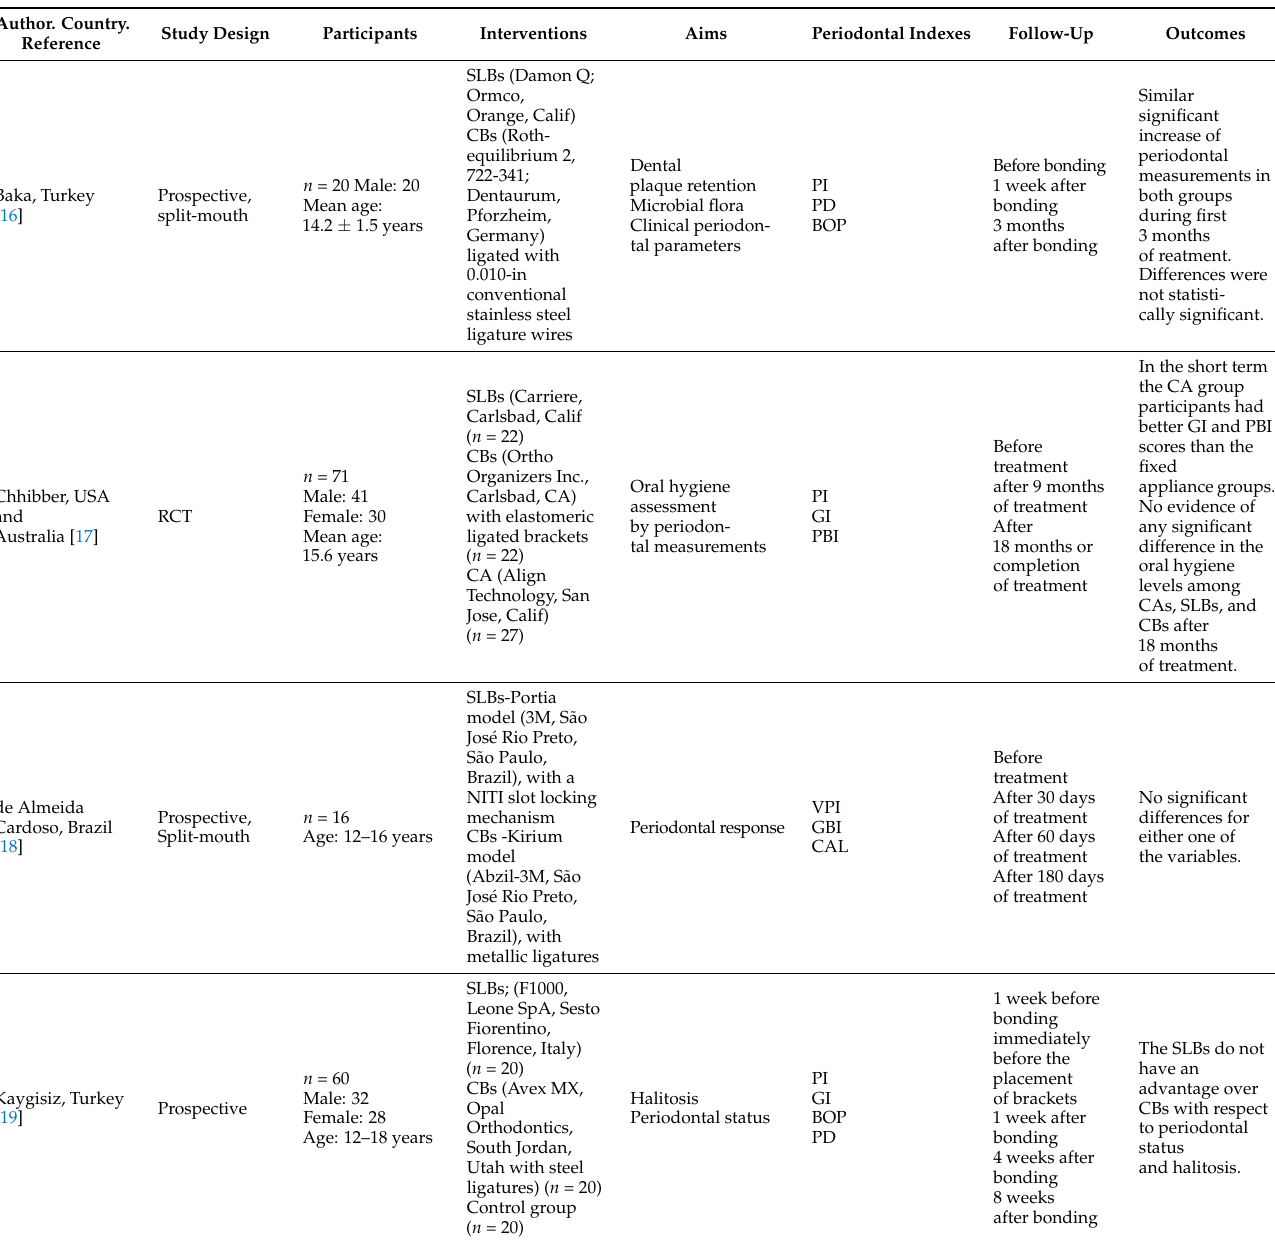
Table 1. Characteristics of the included